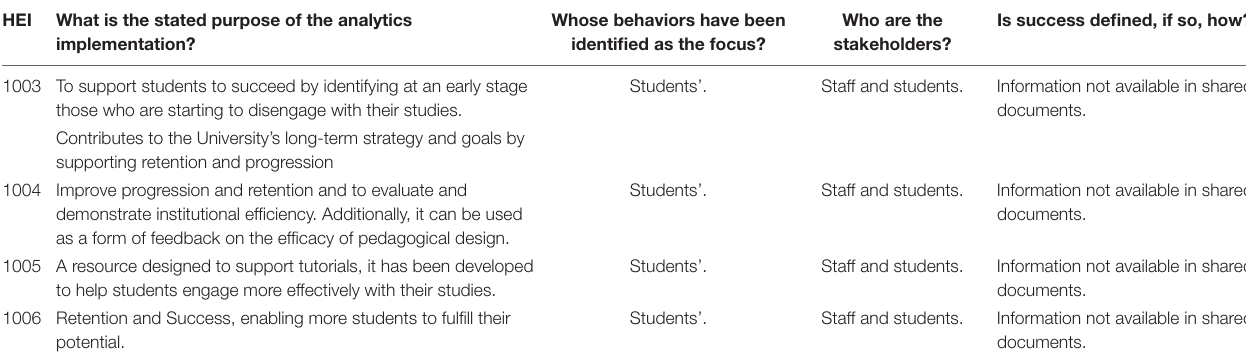
TABLE 6 | Overview analysis of learning